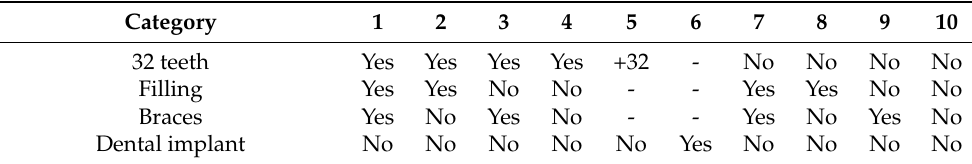
Table 1. Patient